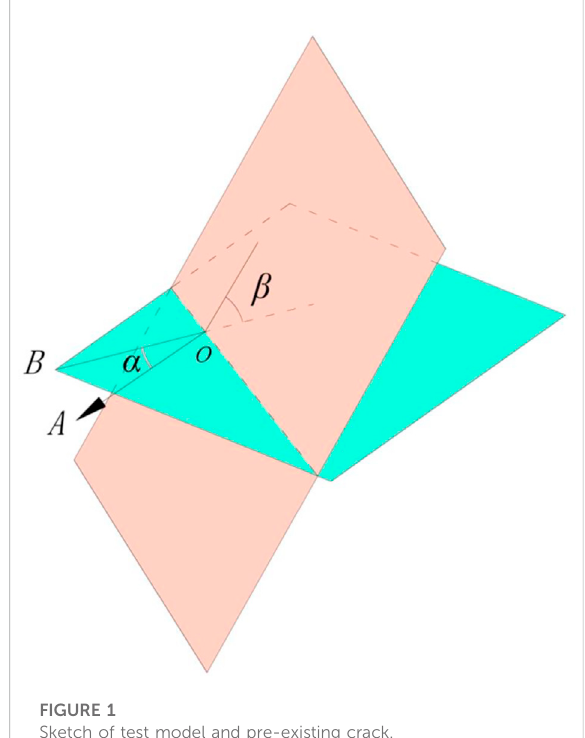
FIGURE 1 Sketch of test model and pre-existing